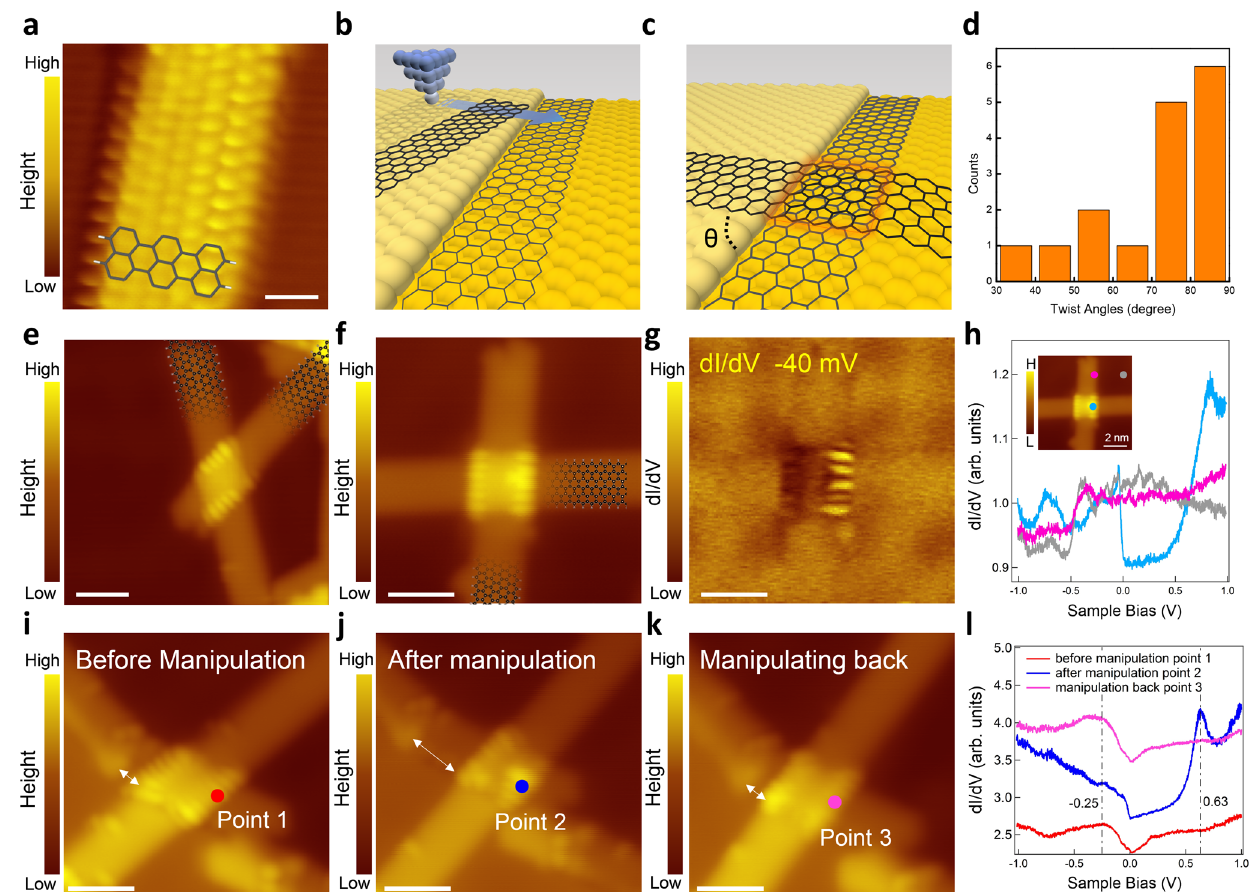
Fig. 2 | TBZGNR junctions obtained by scanning tunnelling microscopy (STM) lateral tip manipulation. a High-resolution STM topography image of the as- grownmonolayerZGNR. b , c SchematicdiagramsofZGNRsnearastepedgebefore and after STM tip manipulation, respectively. d A histogram showing experimen- tally achieved twist angles θ between the top and bottom ZGNRs. e , f STM topo- graphy images of two as-fabricated TBZGNR junctions with the edge states of the top ribbon clearly visualized. The twist angles of these two junctions are 53° and 87°,respectively. g d I /d V mappingimageat − 40mVoftheTBZGNRjunctionshown in f . h Three typical scanning tunnelling spectroscopy (STS) measured on the junction edge (blue), on the edge of monolayer ZGNR (pink) and on the Au (111) surface (grey). Inset: Same STM topography image as f indicates where the STS